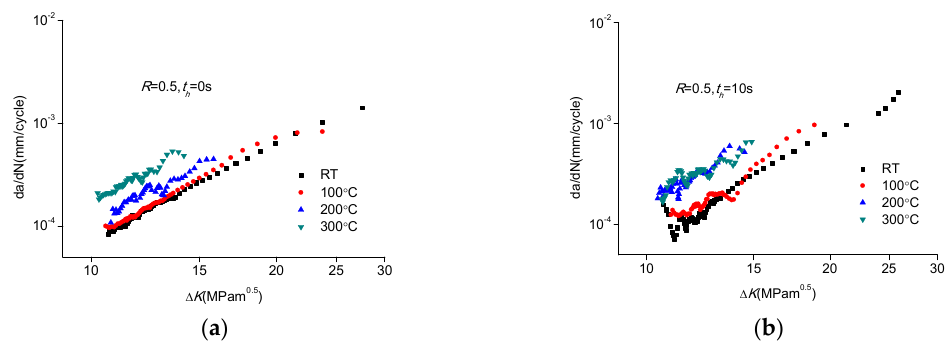
Figure 6. FCG behavior of CP-Ti at different temperatures under high load ratio: ( a ) pure fatigue; ( b ) dwell